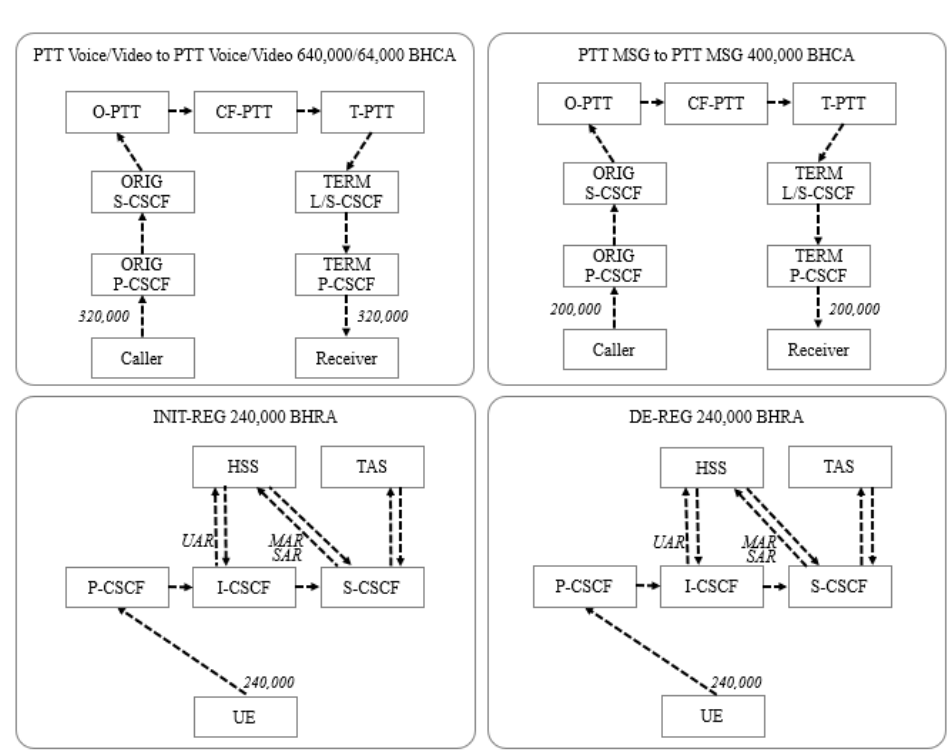
Figure 2. Operating condition of MCPTT simulator. Table 1. MCPTT call model: assuming 400,000 subscriber base.